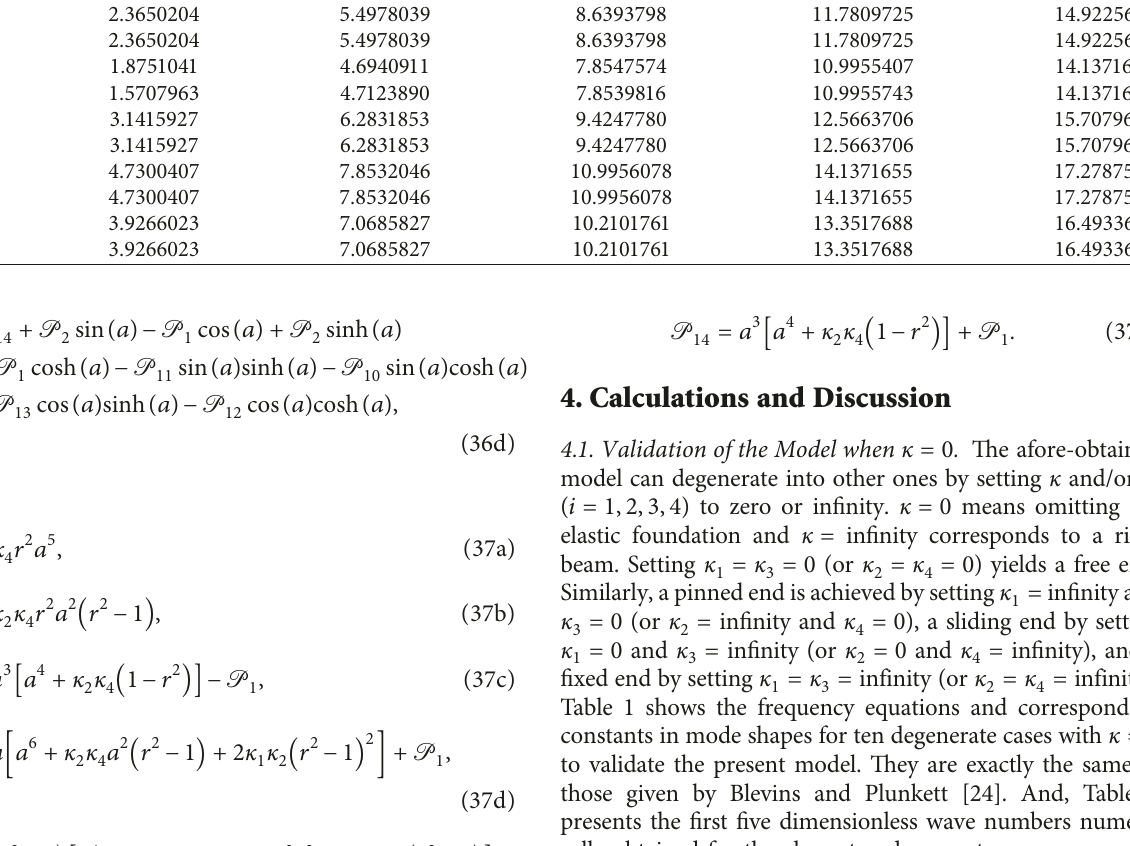
Table 2: First five numerical wave numbers ( a �